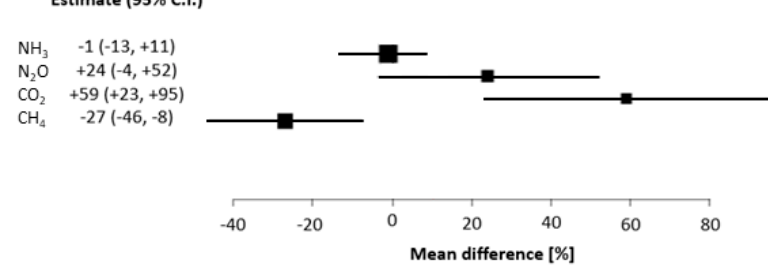
Figure 3. Forest plot of the impact of separation of animal slurry with reference to unseparated slurry. The black square boxes show the individual mean points of each gas. Horizontal bars indicate the 95% confidence